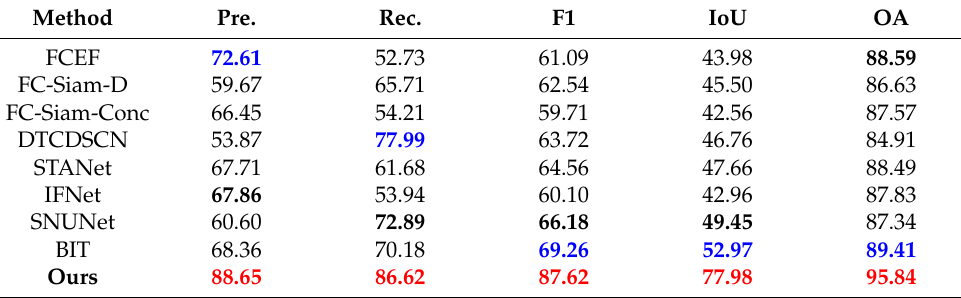
Table 7. The experimental results on the DSIFN-CD test sets *. Method Pre.